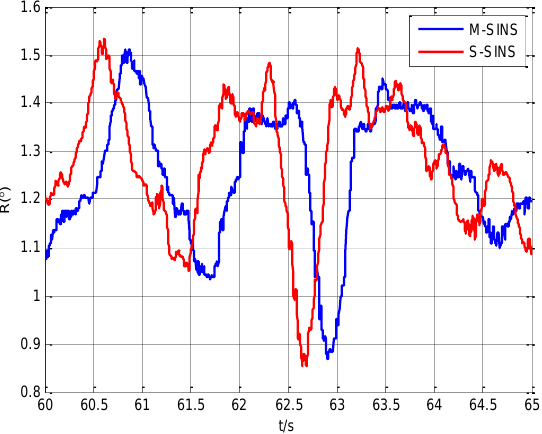
Figure 7. The rolling angles’ curves of M-SINS and S-SINS.